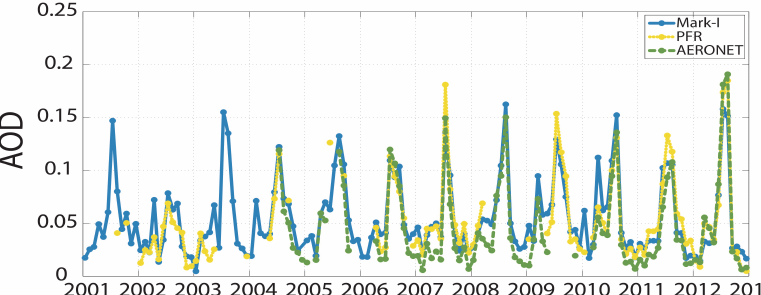
Figure 6. Homogenized AOD monthly means at 769.9nm for Mark-I 2001–2012 (blue); GAW-PFR 2001–2012 (yellow), and Cimel-AERONET 2004–2012 (green).